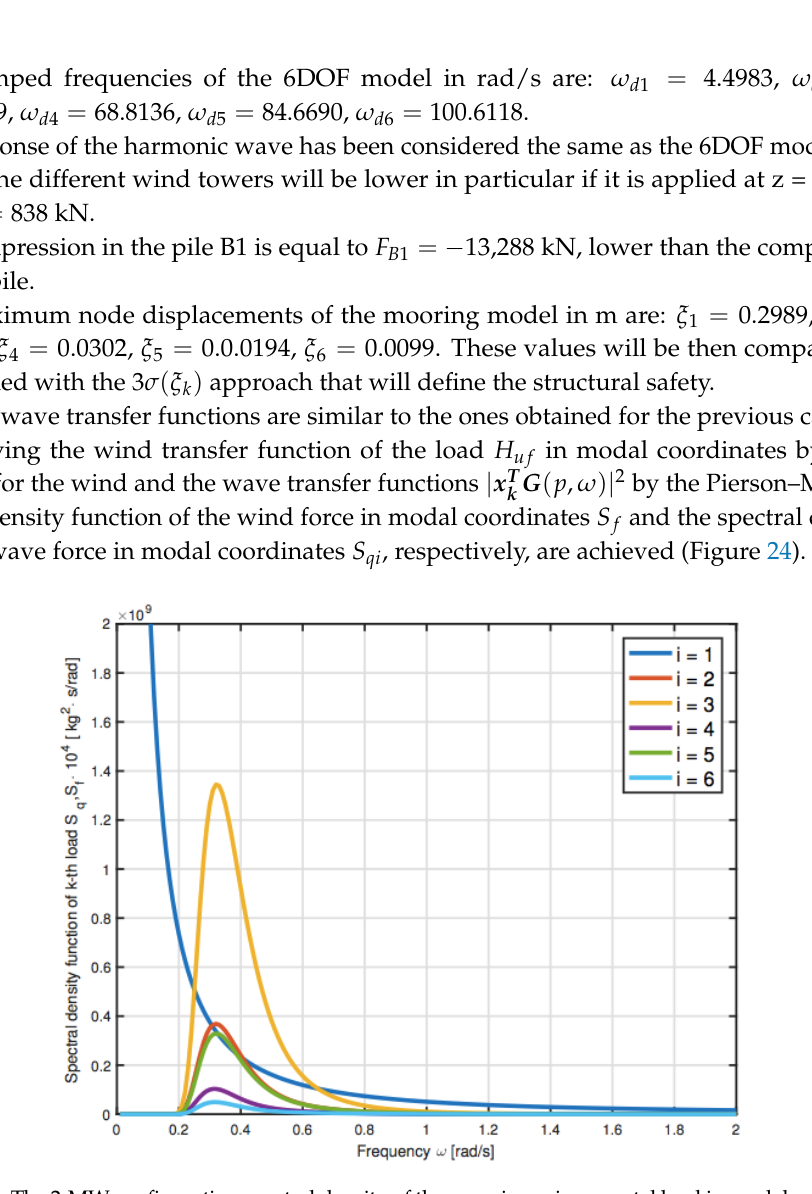
Figure 24. The 2-MW configuration spectral density of the generic environmental load in modal